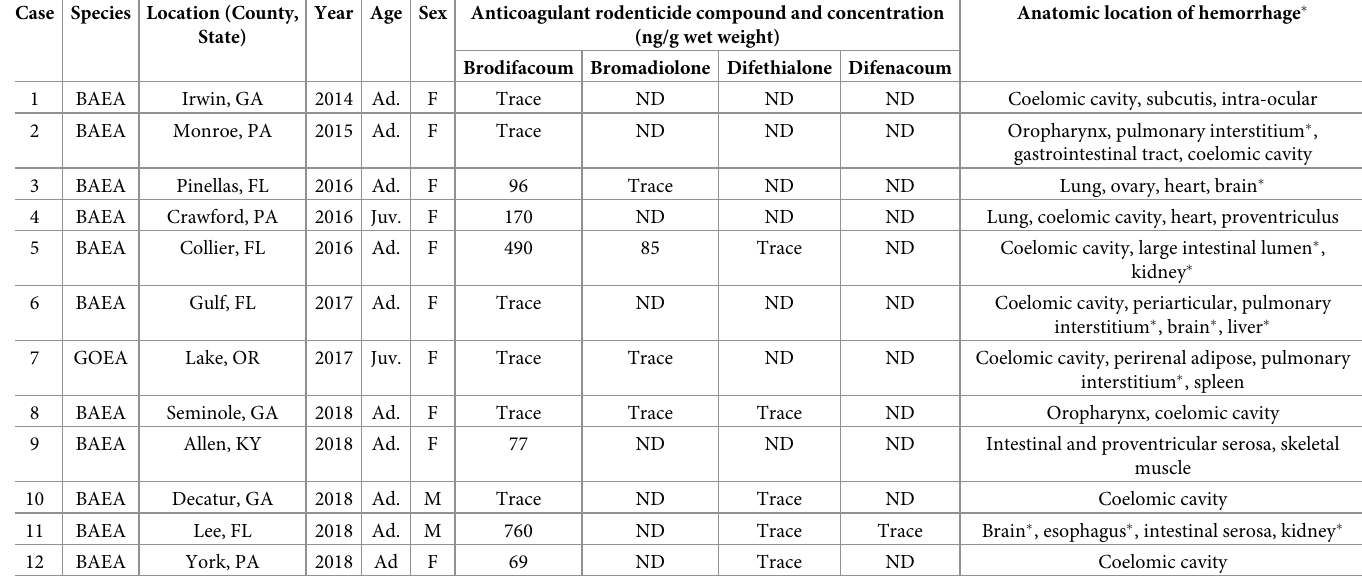
Table 3. Geographic, demographic, anticoagulant rodenticide (AR) compound liver levels, and anatomical location of hemorrhage for bald eagles (BAEA) and golden eagles (GOEA) diagnosed with AR toxicosis that were submitted to the Southeastern Cooperative Wildlife Disease Study (University of Georgia), 2014– 2018. Case Species Location (County,